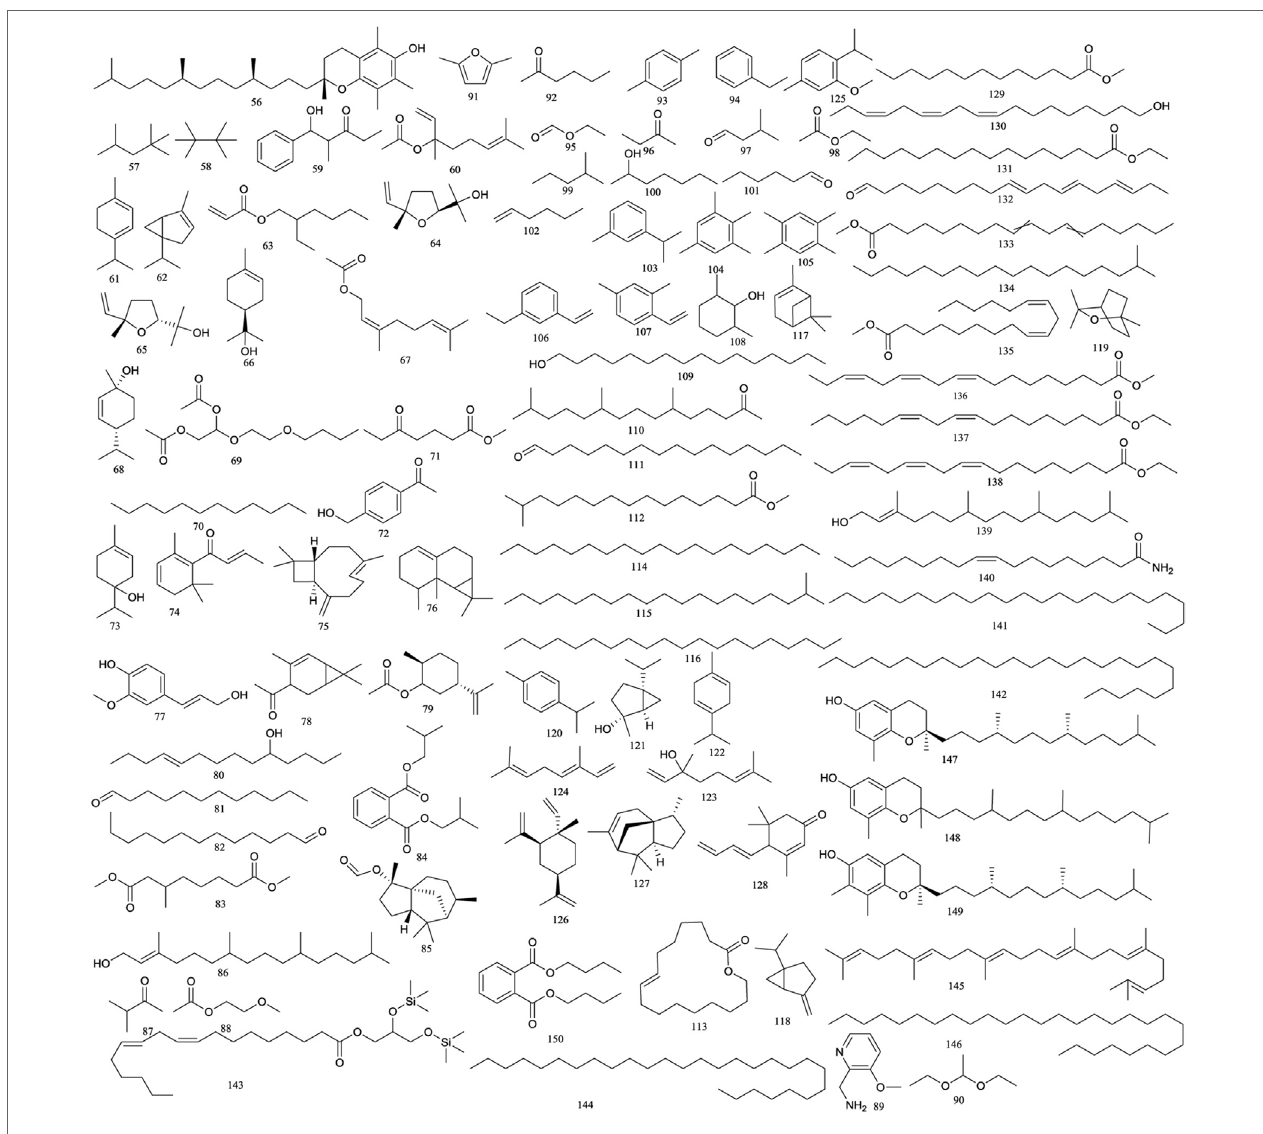
FIGURE 5 | Chemical structures of volatile compounds (56–150) isolated from R. chingii .